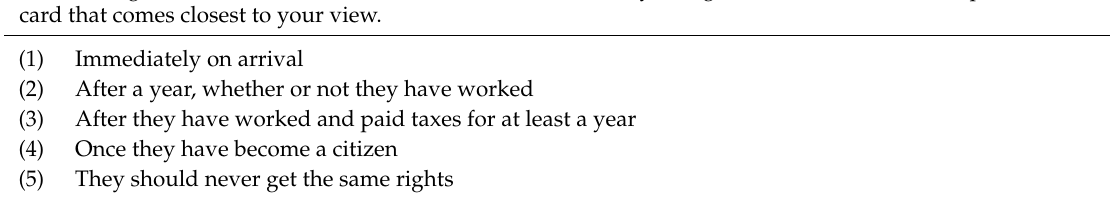
Table 1. Welfare Chauvinism Indicator